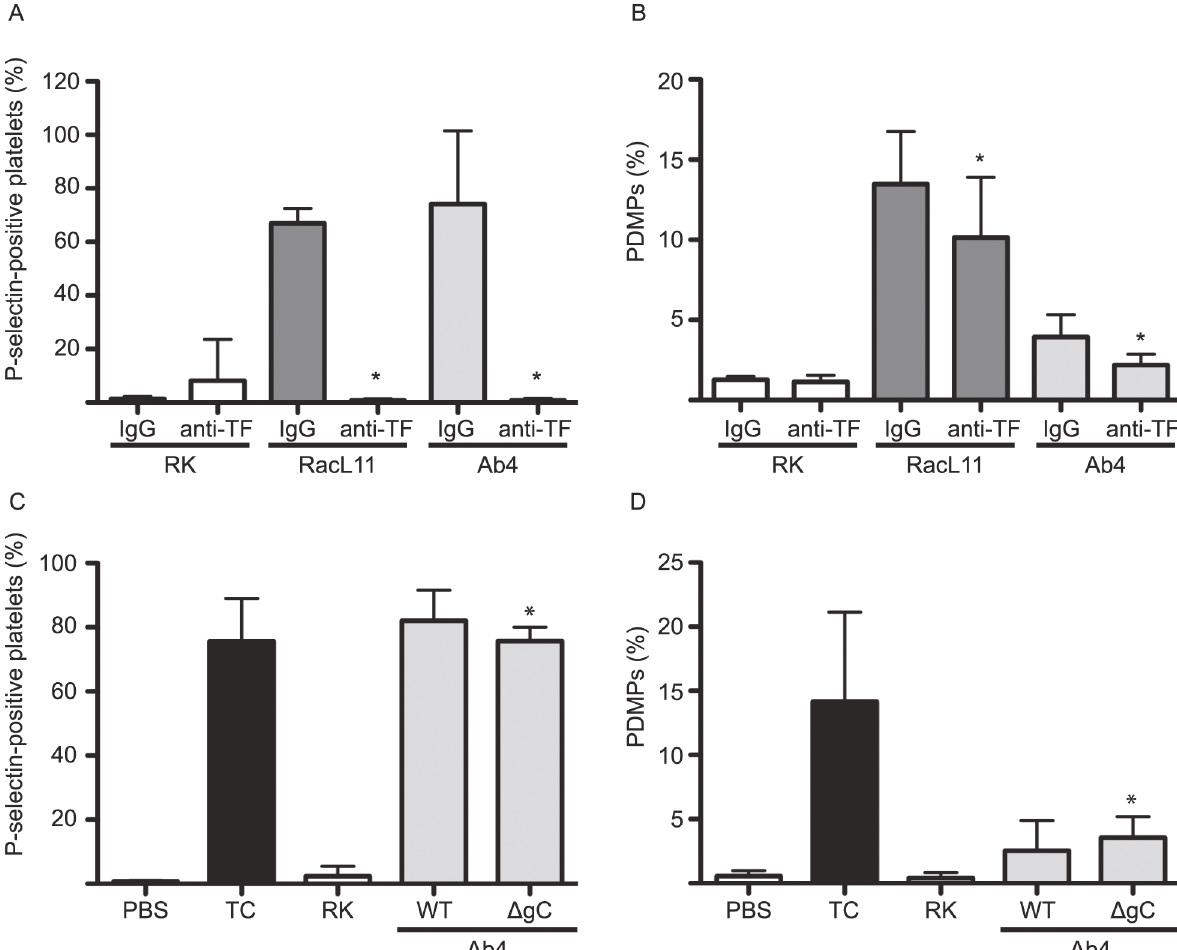
Fig 6. Tissue factor mediates EHV-1-induced platelet activation, with no role for virus glycoprotein C. A goat polyclonal anti-rabbit tissue factor (TF) antibody (anti-TF, 152 ug/mL) abolished P-selectin expression ( A ) and significantly decreased the numbers of platelet-derived microparticles (PDMP) ( B ) in equine platelets exposed to RacL11 and Ab4 EHV-1 strains at 1 PFU/cell (n = 6). Data shown is mean ± SD. * p = 0.033 for RacL11 and p = 0.011 for Ab4 versus goat IgG controls. In contrast, platelets still expressed P-selectin ( C ) and shed PDMPs ( D ) when exposed to an Ab4-based envelope glycoprotein C deletion mutant ( Δ gC) at 1 PFU/cell. The deletion mutant induced stronger vesiculation and lower P-selection translocation than wild type Ab4 (WT) (n = 8). Data shown is mean ± SD. * versus Δ gC